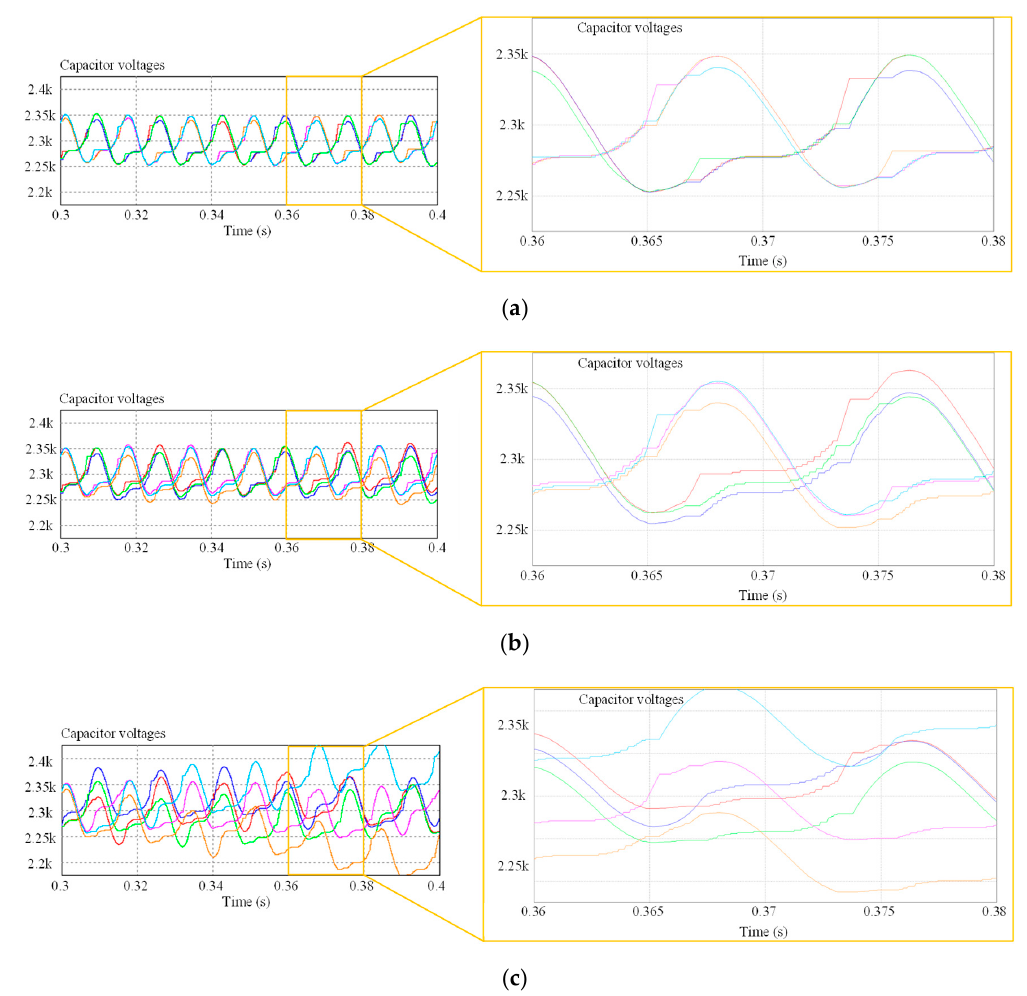
Figure 7. The magnification of SM capacitor voltages: ( a ) without switching loss balancing control; ( b ) with switching loss balancing control; ( c ) without using optimal weighting factor w 0 and tolerance band.